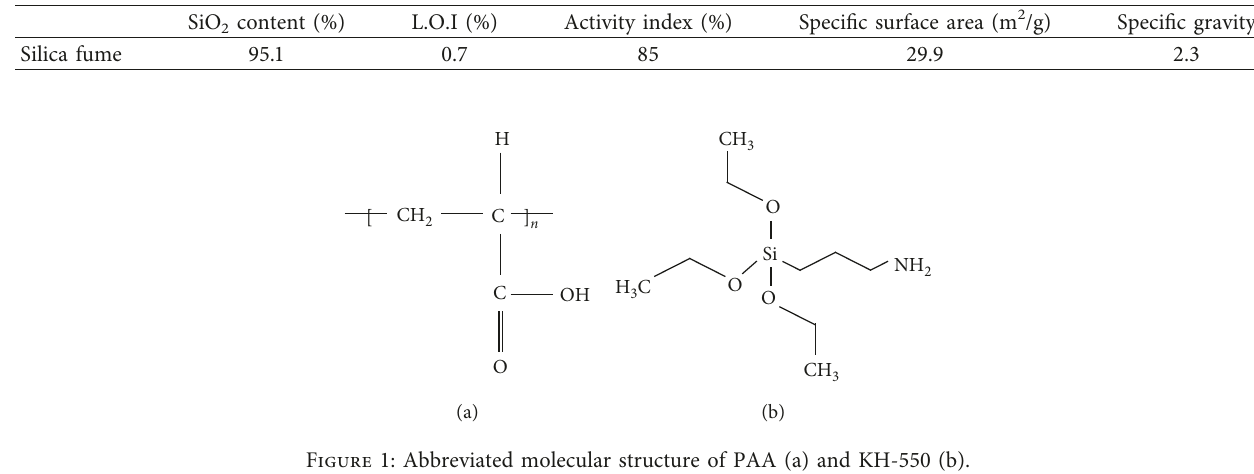
Table 1: Chemical and physical indexes of SF.